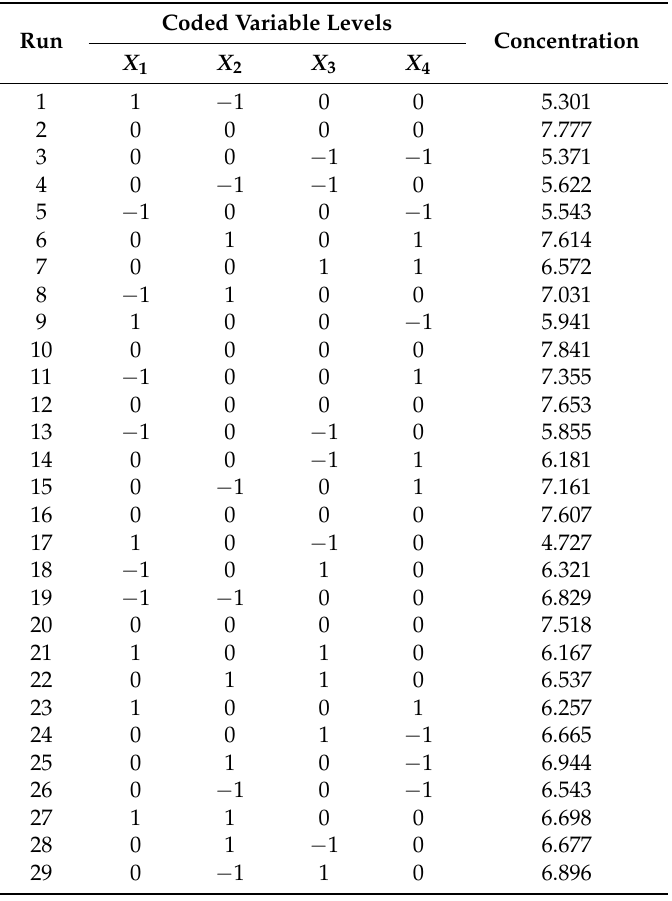
Table 1. Box-Behnken experimental design with the independent